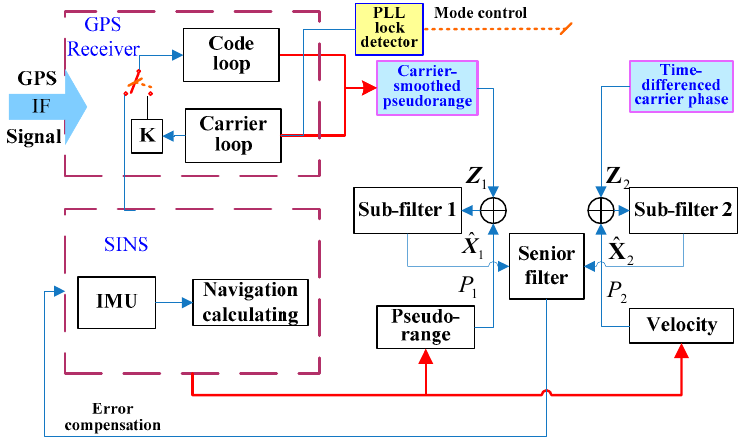
Figure 1. Innovative scheme for the GPS / MEMS-SINS ultra-tight integrated system. GPS: global positioning system; MEMS-SINS: microelectromechanical system–strapdown inertial navigation system; IF: intermediate frequency; K:switch; PLL: phase lock loop; IMU: inertial measurement unit; Z:measurement; P:variance matrix.